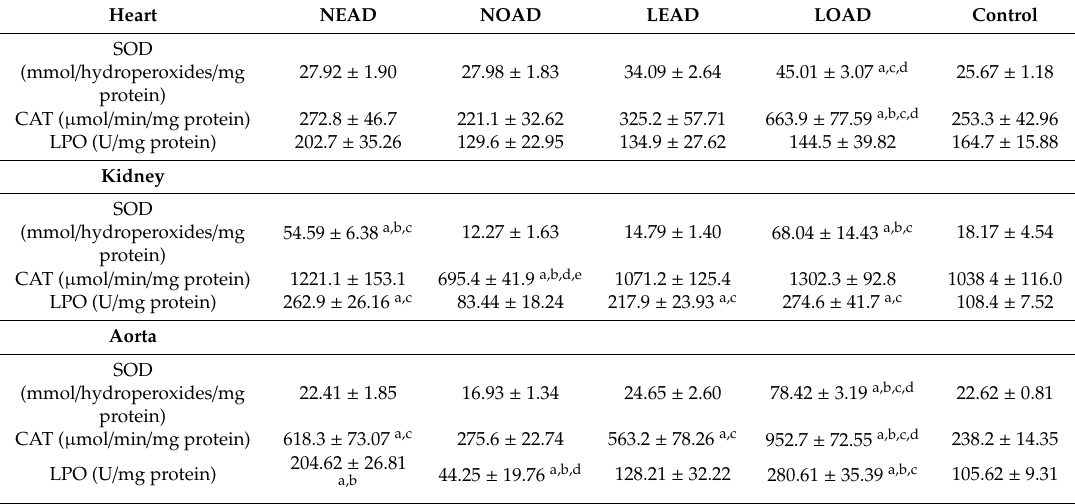
Table 8. Tissue redox status in the various groups over 60 days of